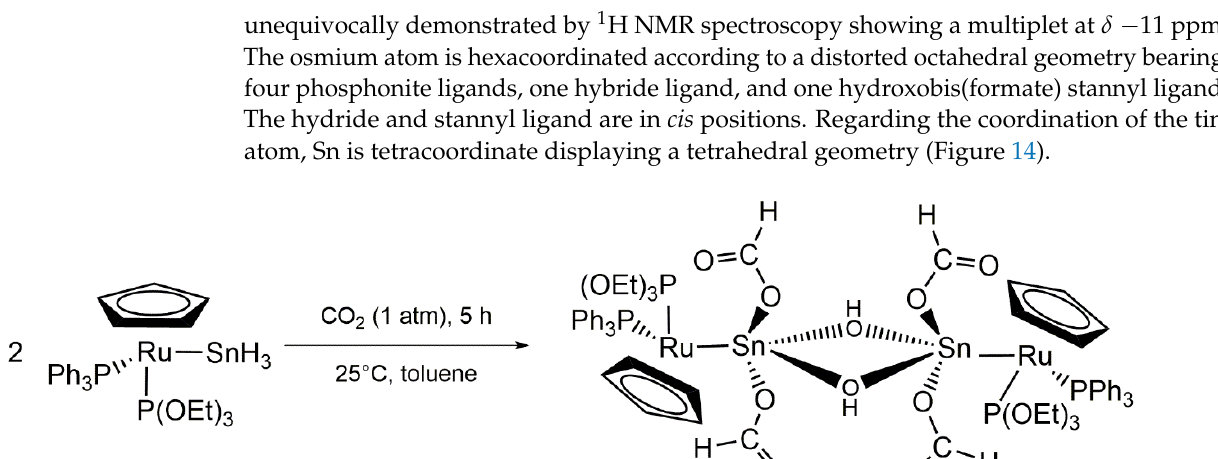
Figure 12. Molecular structure of 9 , adapted from [63] (MERCURY view). Hydrogen atoms are omitted for clarity except those of hydroxyl and formate groups (Re blue, Sn light blue, O red, P orange, C grey, H white).